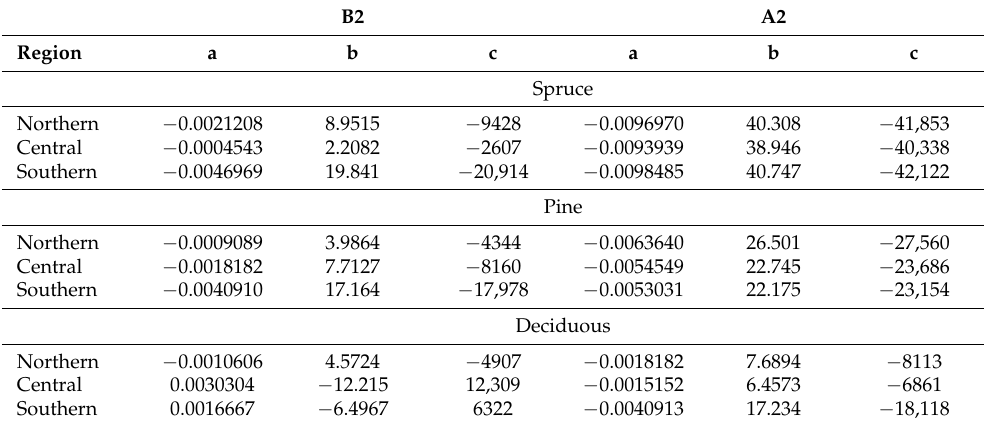
Table 2. Functions for relative change of production for B2 and A2 scenarios for different regions and species.